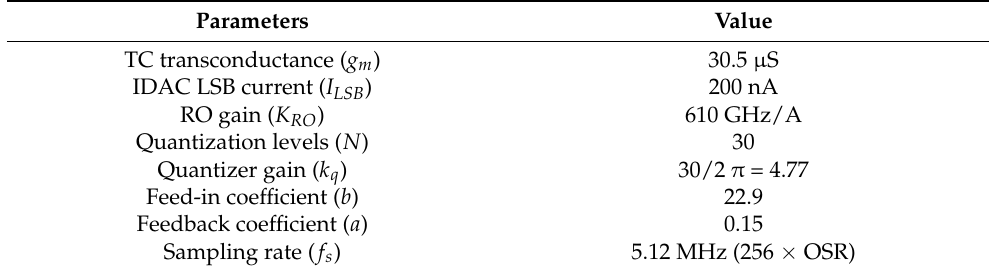
Figure 1. ( a ) Block diagram of proposed VCO-based CTDSM. ( b ) Simplified diagram of modulator. Table 1. High-level modulator design